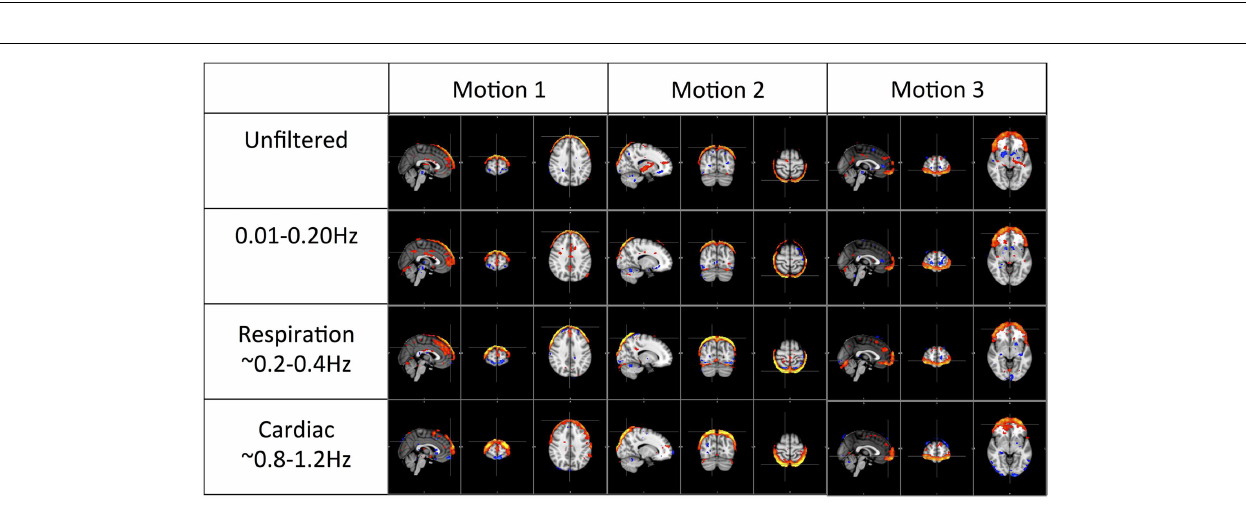
FIGURE 5 |Three prominent motion-related physiological ICs identified from the unfiltered data (in top panel) and their corresponding ICs selected from the ICA result of the filtered data